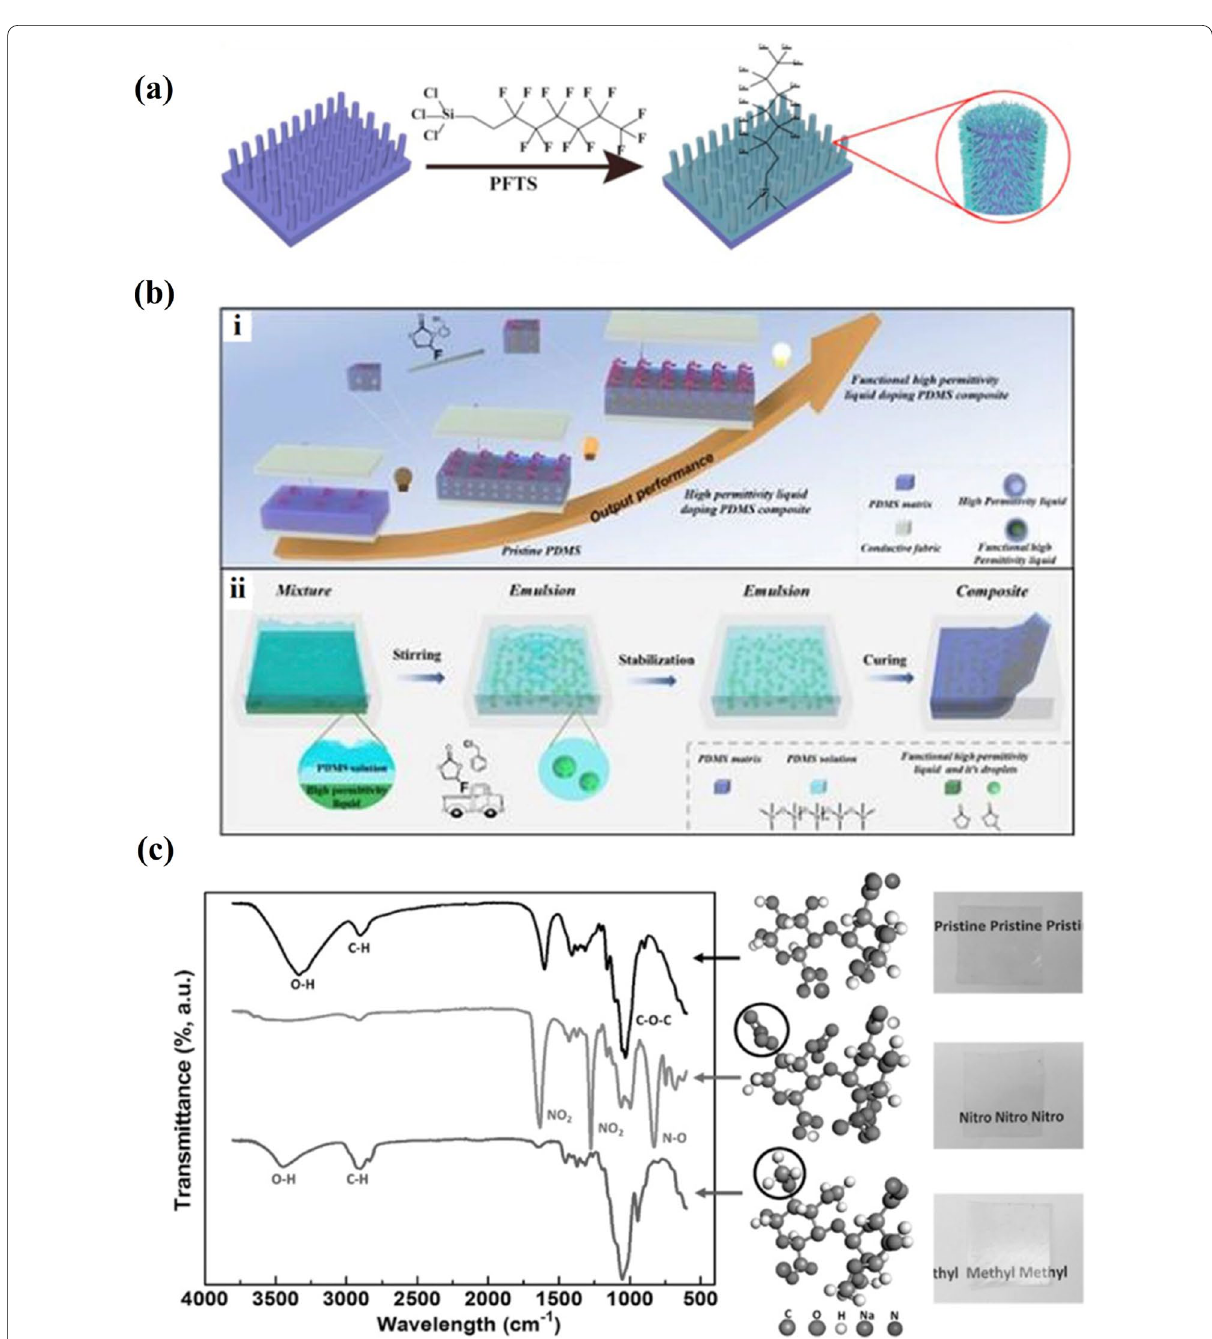
Fig. 13 Chemical functionalization of TENG surface layer. a Schematic depiction of the surface modification with fluorinated compounds of the PP nanowires prepared by hot processing technique (Reproduced with permission from Ref. [86]). b i—Scheme of functional high permittivity liquid doping PDMS composite; ii—Fabrication of high permittivity liquid doping PDMS composite and fluorine functionalization (Reproduced with permission from Ref. [87]). c FTIR spectrum and molecular structure of pristine CNF (top row), nitro-CNF (middle row), and methyl-CNF (bottom row). Photos of the transparent films fabricated from these three cellulosic materials (Reproduced with permission from Ref.